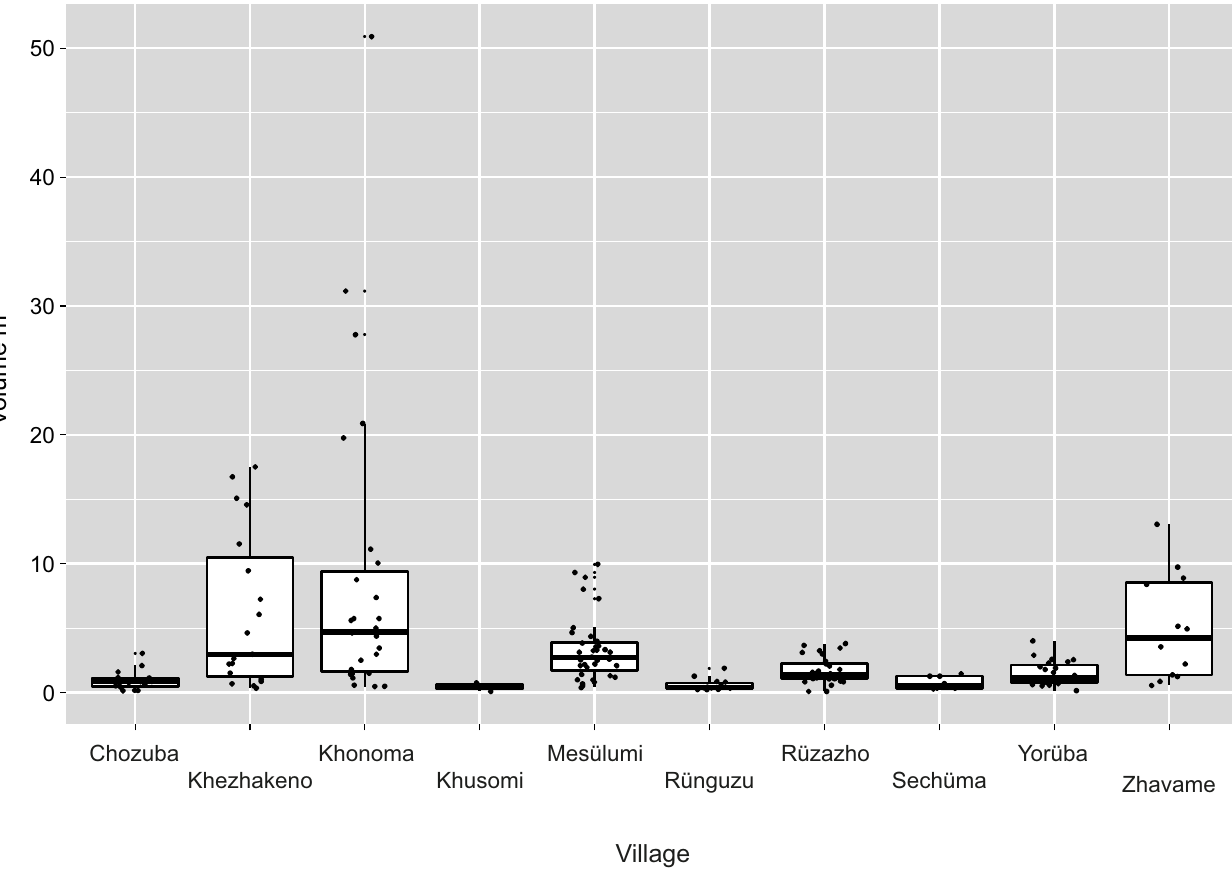
Fig 20. The size distribution (m 3 ) of stone rows with and without attached platforms in the different villages visited in 2016. Khonoma and Sechu¨ma are Angami Naga villages; the remainder are Chakhesang Naga villages (Graphic: M. Wunderlich).